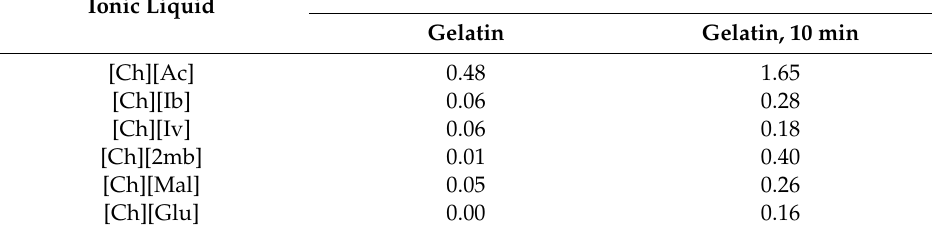
Table 2. Ionic conductivities ( κ ) of ILs in membranes. The conductivity was measured right after immersing the membrane materials into ILs in an inert atmosphere and after 10 min in ambient